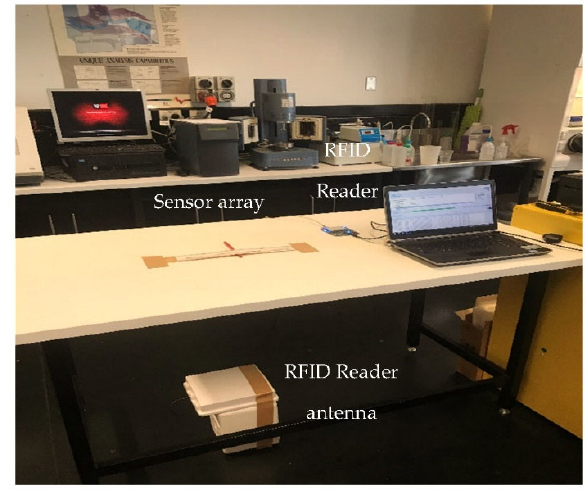
Figure 12. Test platform for bending detection.